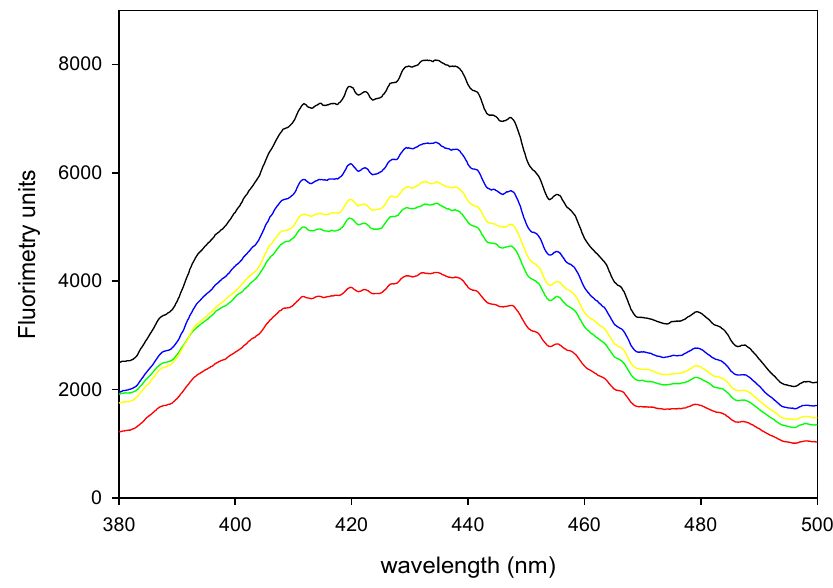
Figure 1. Fluorometric spectrum of samples of PO30 diluted 1:2 (black), PO3x15 diluted 1:4 (red), PB30 diluted 1:2 (green), PB3x15 diluted 1:4 (yellow) and PN90 diluted 1:2 (blue). Table 1. Bleaching products diffusion.